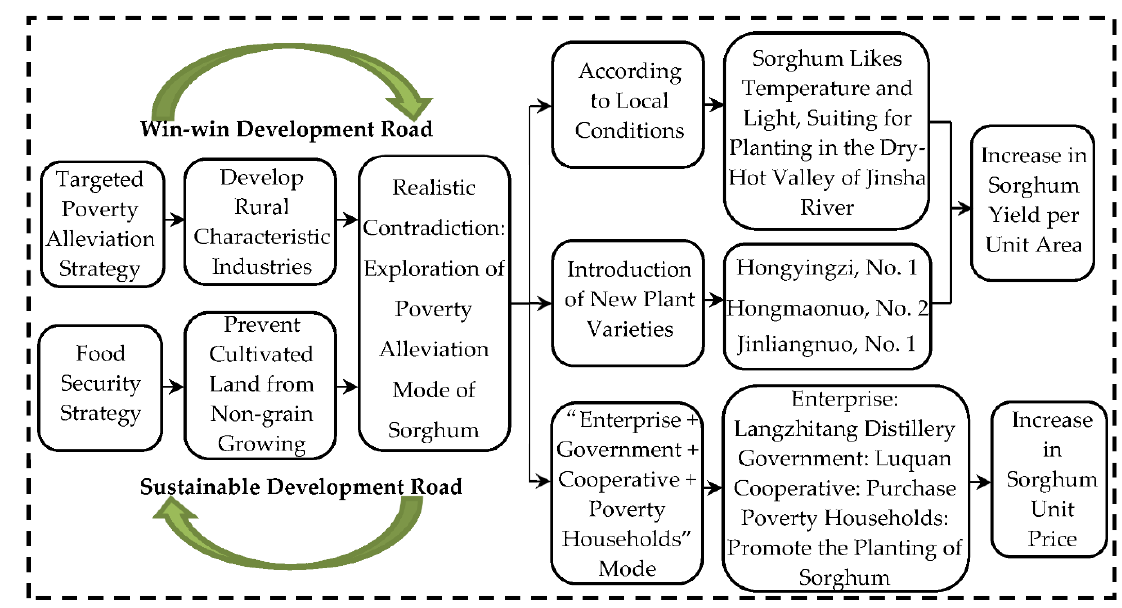
Figure 1. Sustainable Mode of Sorghum Planting Industry Leading Poverty Alleviation in the Dry-Hot Valley Area of Jinsha River in Luquan County.